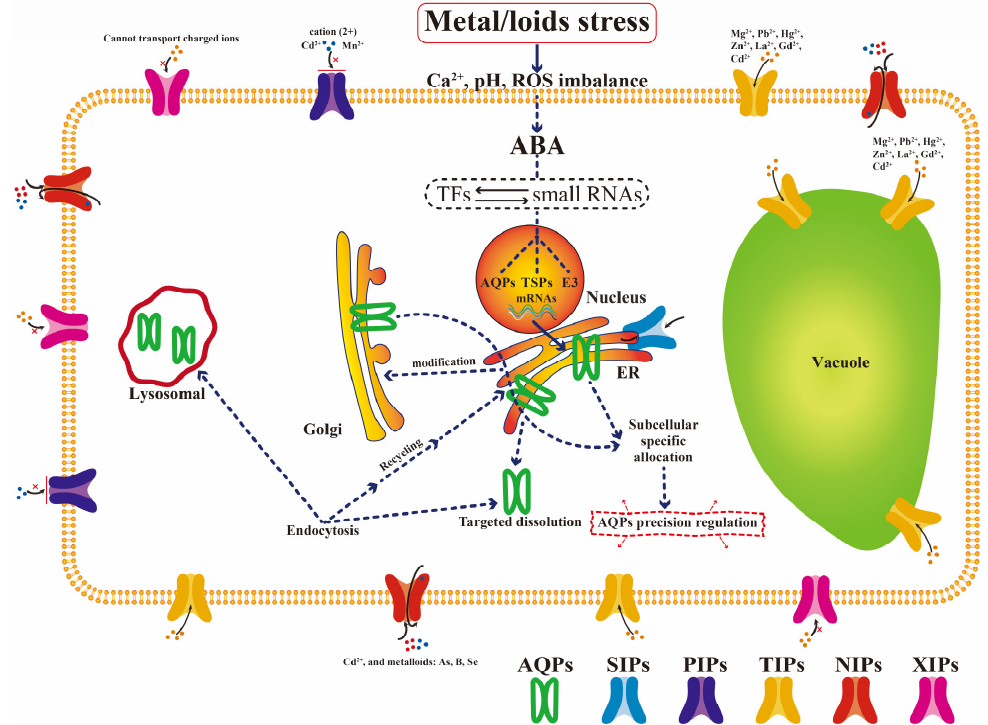
Figure 3. Coordinated response regulation model of AQPs of different subgroups under HMS. The underlying regulatory mechanisms are simply explained, including transcription, translation, inhibition, degradation, endocytosis, and exocytosis. SIPs: subcellular localization in the plasma membrane and ER membrane [71]. PIPs: plasma membrane; prevent the influx of divalent metal ions into the cytoplasm, especially Cd and Mn [72]. TIPs: vacuolar membrane; plasma membrane; represents the detoxification of compartmentalized HMs [73]. NIPs: plasma membrane; specific recognition and transport of As, B, Se and other metals, such as Cd ions [74]. XIPs: plasma membrane; charged ions may not be transported [75]. TSPs: tryptophan-rich sensory proteins; E3: Rma1H1 (a RING membrane anchor E3 ubiquitin